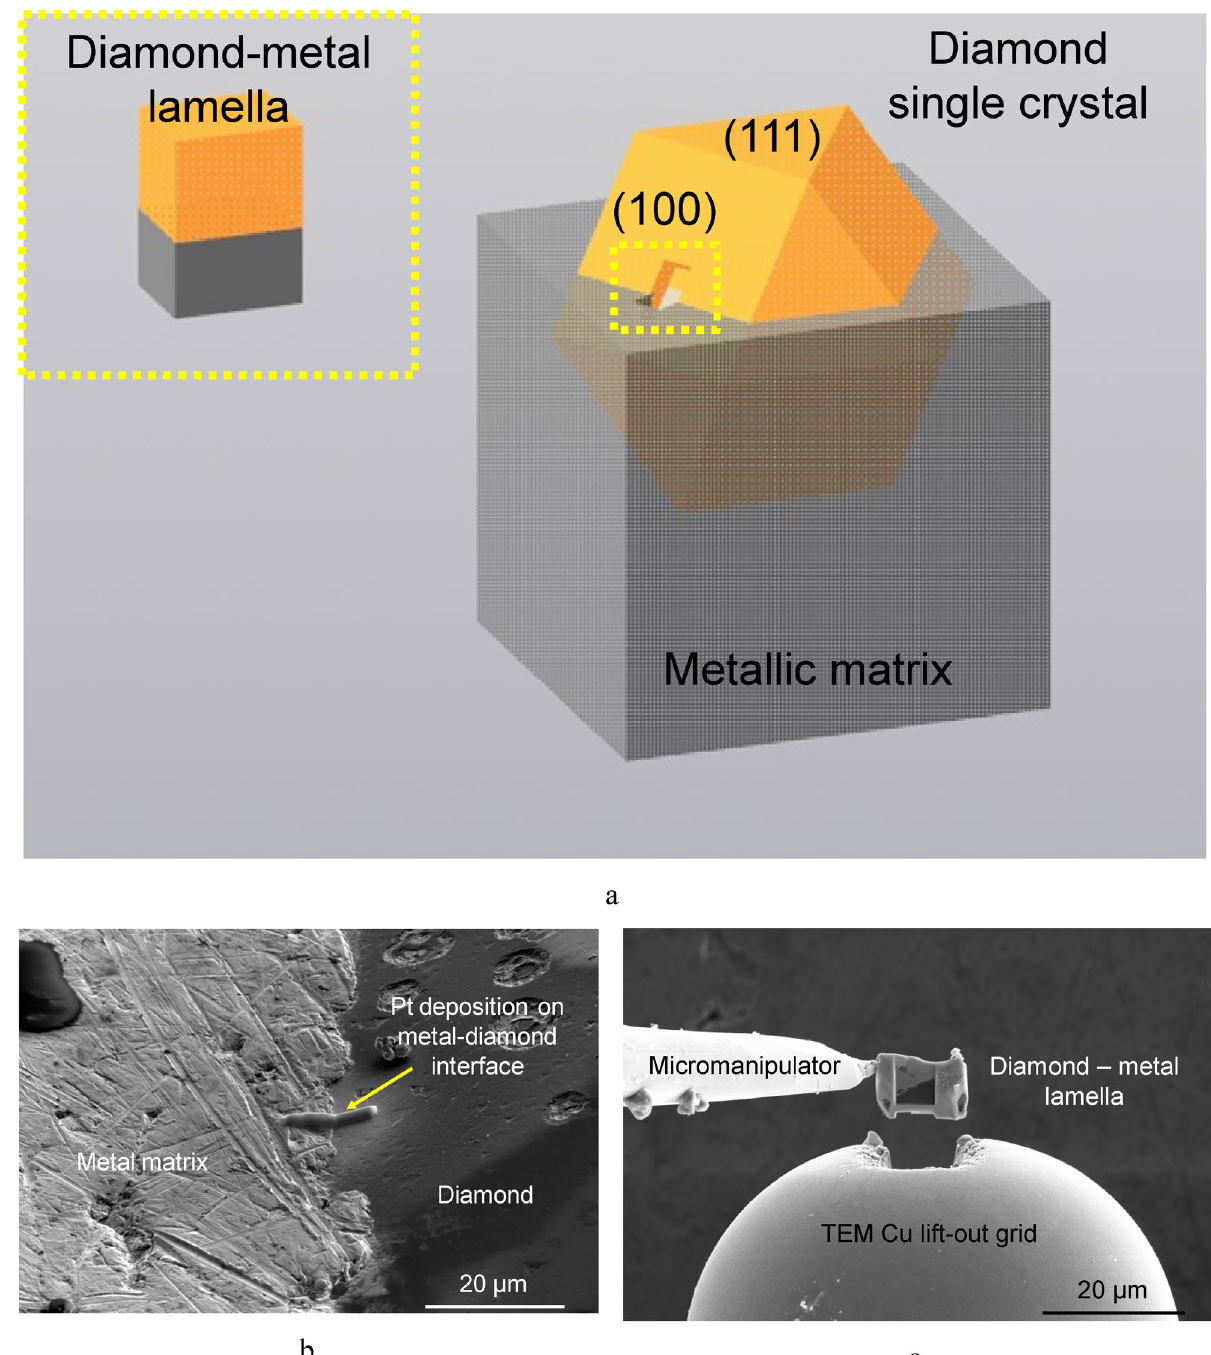
Figure 2. A schematic image of the original bulk metal–diamond composite ( a ) and the stages of preparing the metal–diamond lamella for the in situ tensile tests: depositing the Pt mask onto the sample surface within the interface ( b ); removing the lamellae with a micromanipulator and attaching it to the copper lift-out grid to perform additional thinning ( c ); securing the lamella to the PTP device (at a 10° tilt angle) ( d ); FIB-shaping of the lamella ( e ) ( a —Kompas-3D v.17; https:// kompas. ru/; b – e